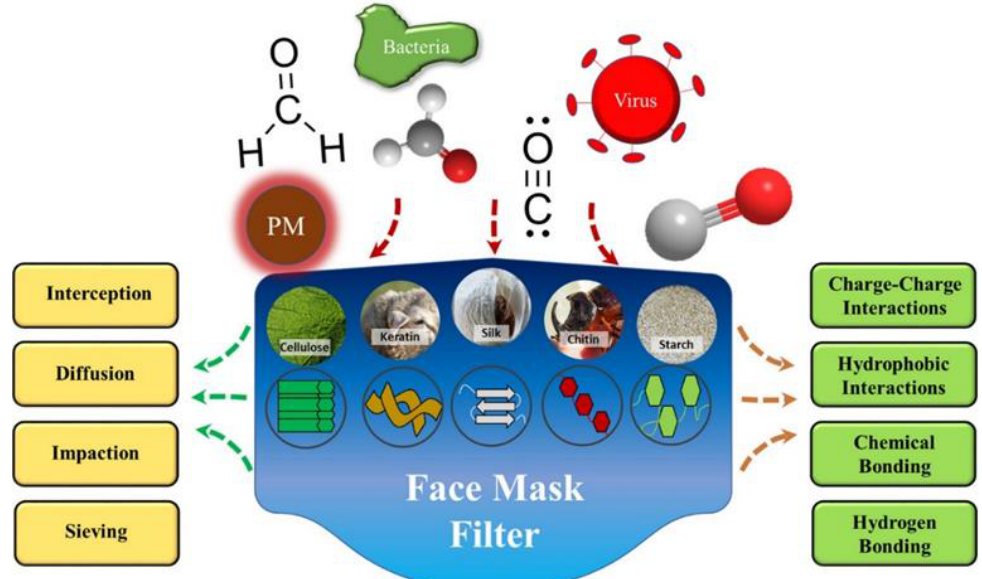
Figure 5. Principal biopolymers used in filtration applications, and their interaction mechanisms with the micro-organisms (virus and bacteria) and other toxic particles. Reproduced with permission from [80].